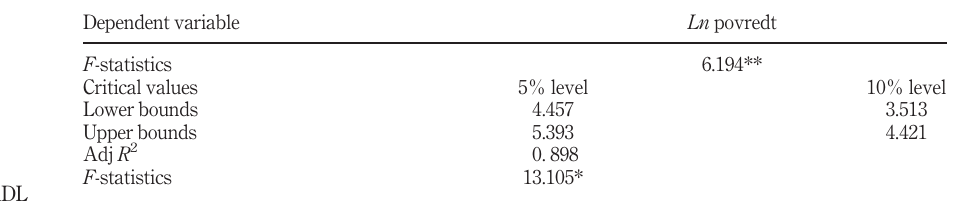
Dependent variable = Ln povredt Long-run